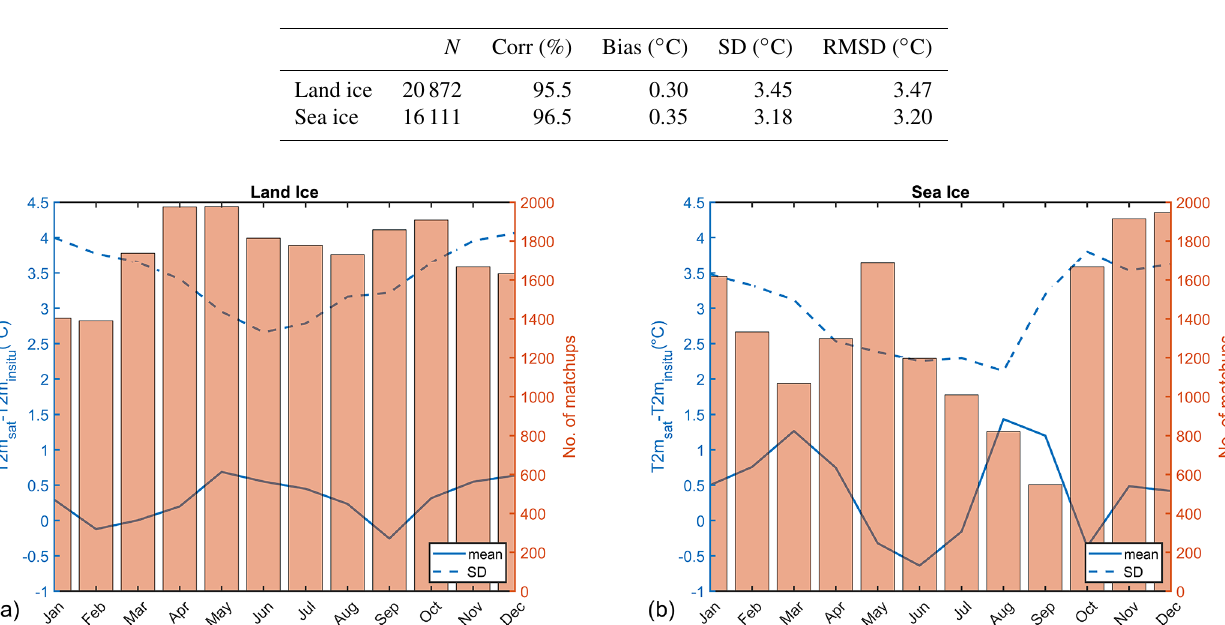
Table 6. Statistics on the relation between satellite-derived and in situ measured temperatures for comparison with independent validation data. N : number of matchups used for validation; Corr: correlation; bias: T2m sat –T2m insitu difference; SD: standard deviation; RMSD: root-mean-square difference.